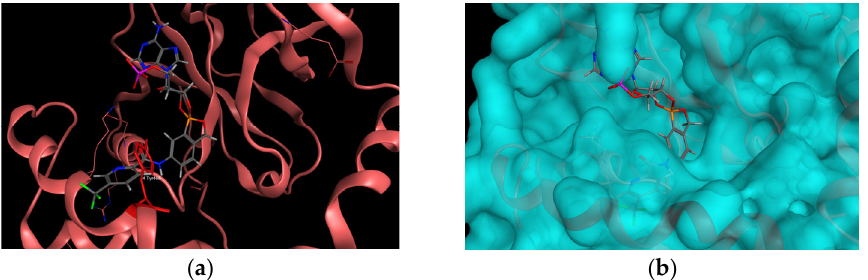
Figure 4. ( a ) The pose of one of the template-docked compounds, compound 11 (grey) into mtbLeuRS (PDB ID: 5AGR, the original co-crystallized ligand in green) interacting with D447. ( b ) The same pose with the calculated surface.